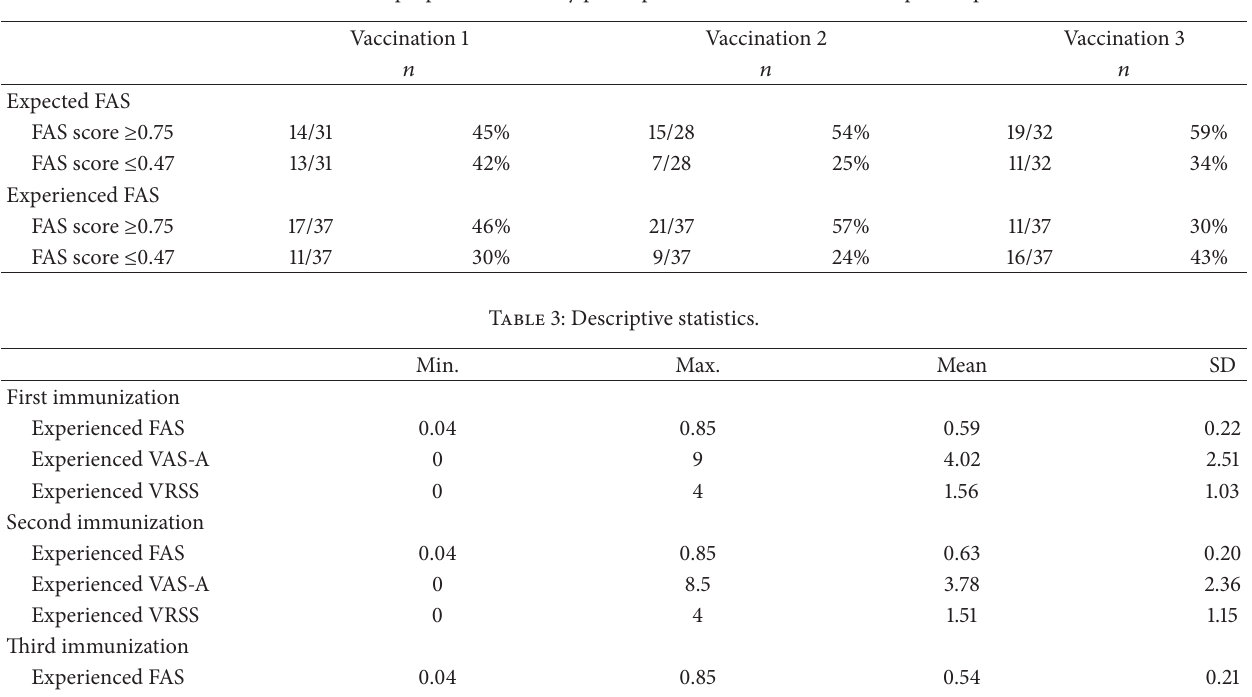
Table 2: The number and proportions of study participants who did or did not feel pain unpleasantness.